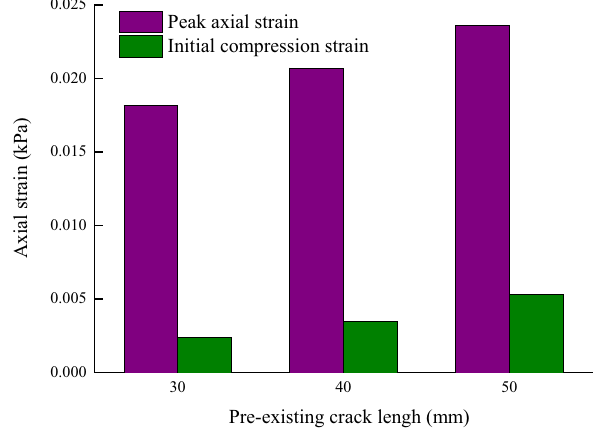
Fig. 7 The change of the peak axial strain and initial compression